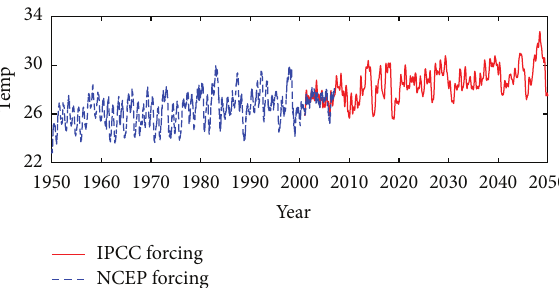
Figure 5: The simulated SST in Nino3.4 region from 1950 to 2006 (Blue) forced by NCEP atmospheric forcing and simulated SST from 2001 to 2050 (red) forced by IPCC-AR4 SERS A1B atmospheric forcing using HYCOM